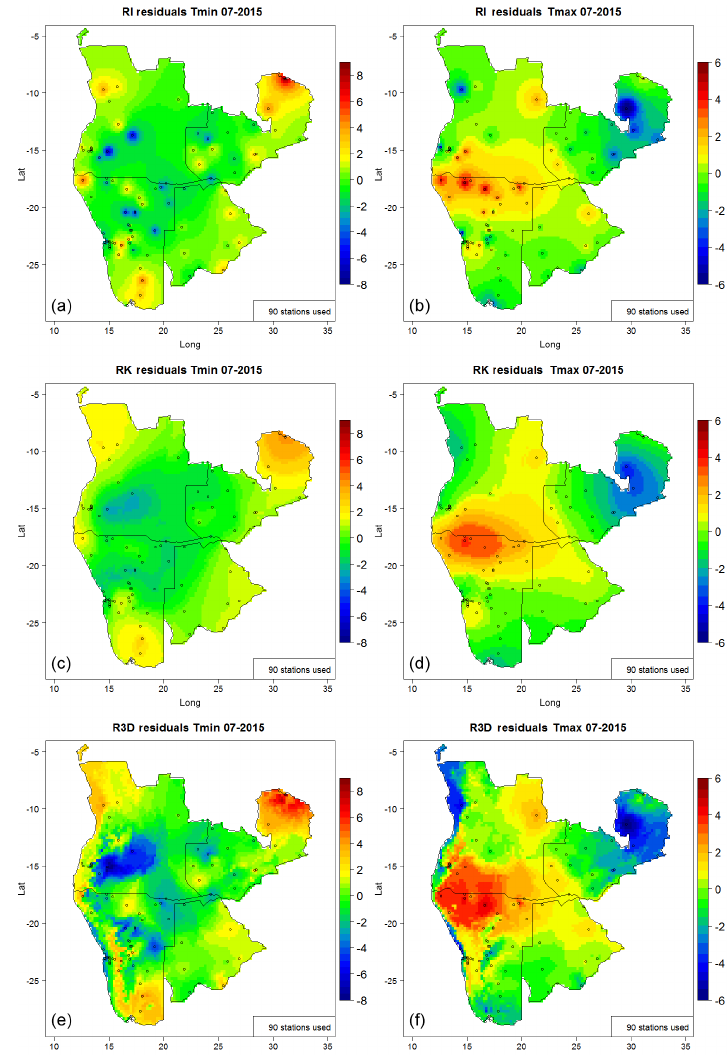
Figure 4. Maps of the interpolated residuals of RI (a, b) , RK (c, d) und R3D (e, f) in July 2015, for minimum temperature (a, c, e) and maximum temperature (b, d, f) .